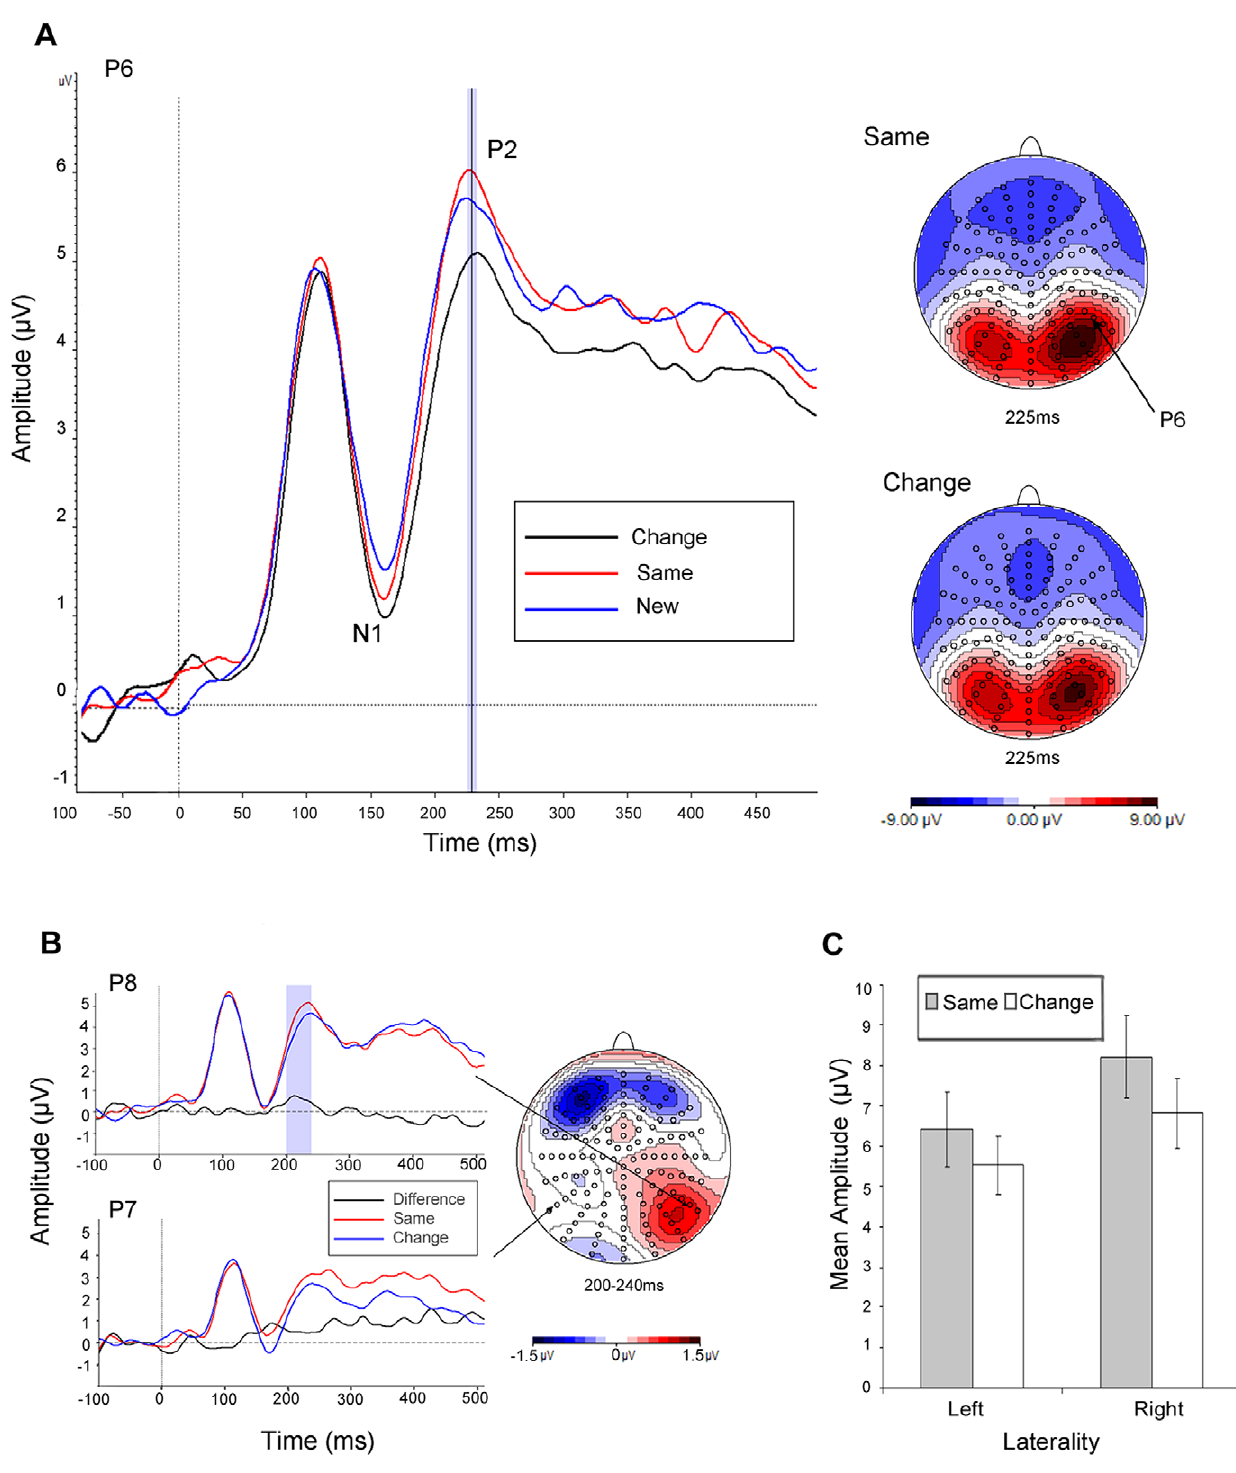
Figure 2. ERP Shape + colour repetition effects. (a) Grand average ERPs to same (red line) versus change (black line) stimuli plotted between 2 100 and 500 msec, with respective topographies for the P2 at peak amplitude; (b) topography associated with the difference in mean amplitude for the same versus change contrast over the highlighted 40 msec epoch for the P2; (c) mean amplitudes across posterior electrode clusters during the P2 as a function of laterality and transformation.